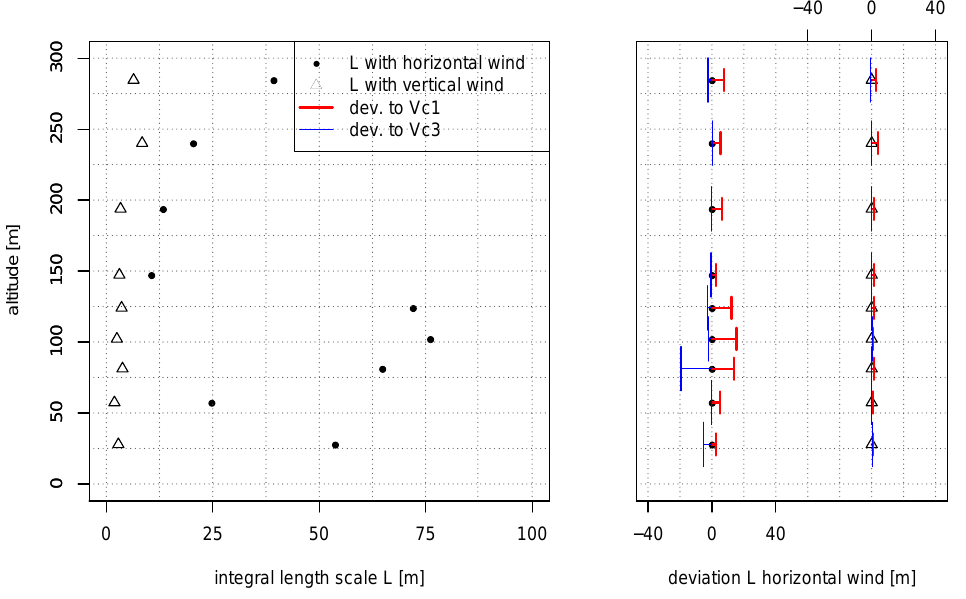
Figure 9. Height profiles of the ISOBAR flight with the altitude AMSL of the integral length scale of the horizontal windspeed L ( v h ) and the vertical windspeed L ( w ) , calculated with the calibration polynomial at v c 2 ( left ). Deviations ( right ), when applying the calibration polynomials at v c 1 and v c 3